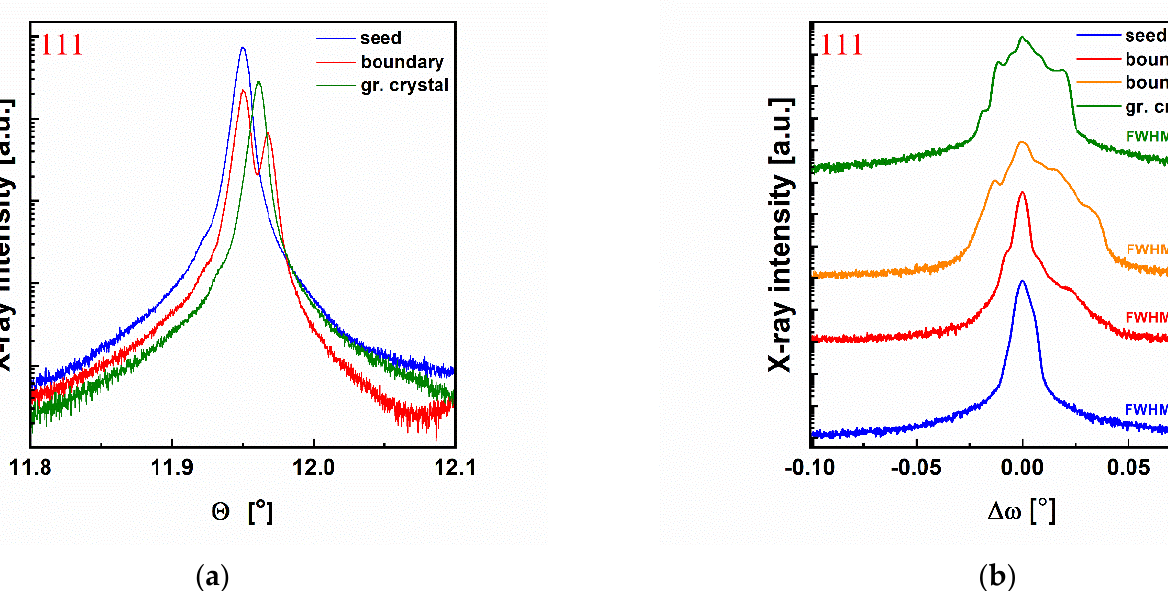
Figure 2. HRXRD θ -2 θ scan ( a ) and ω scan ( b ) at the three positions of F1-02. The splitting of the peak at the boundary and the shifting of the peak position in the grown crystal from the θ -2 θ scans indicate the variation in lattice parameter. The broadening and diffuse scattering of the peaks from the ω scans suggest the existence of more defects in the grown crystal region.